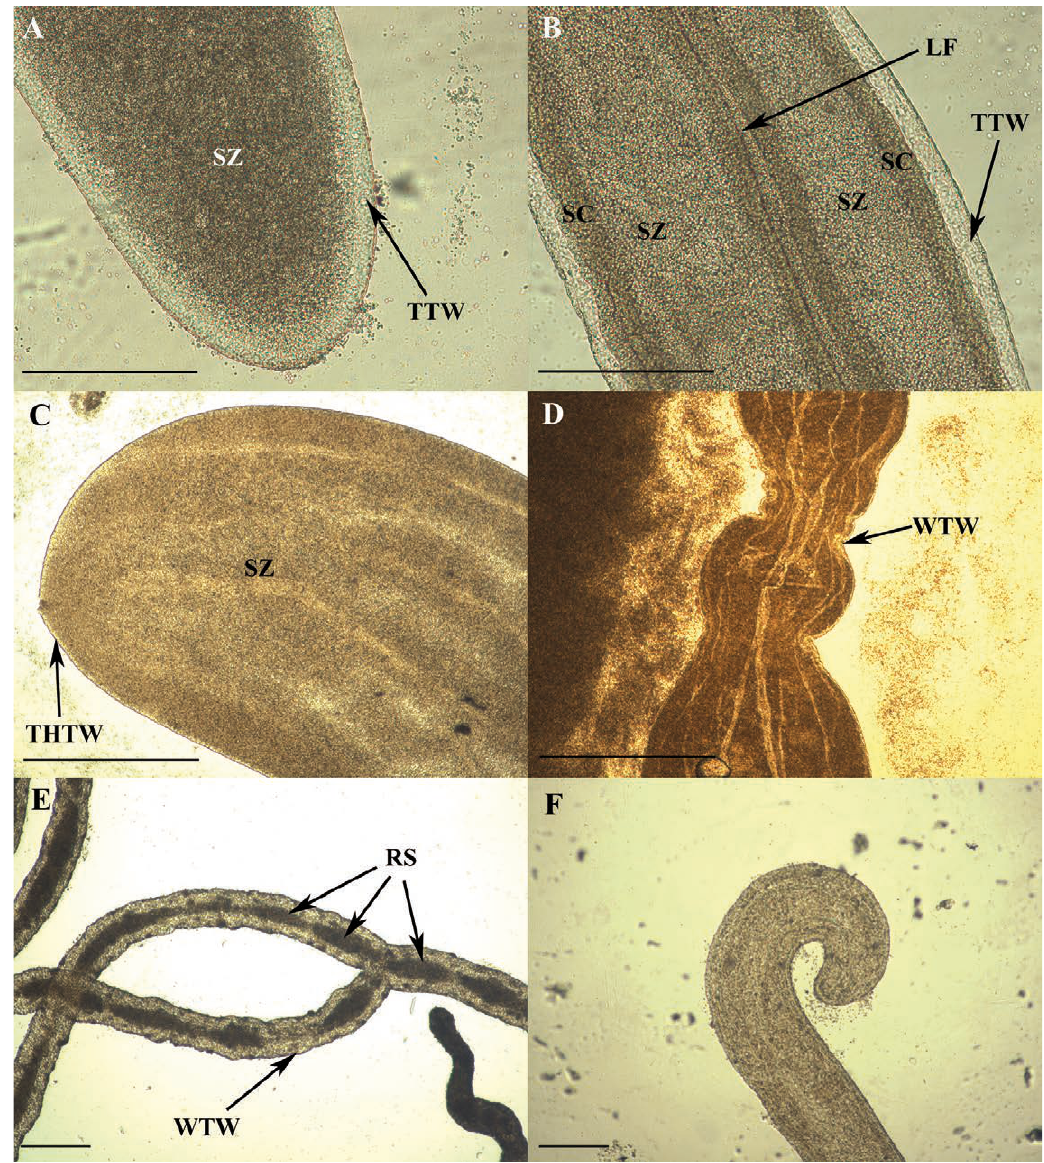
Fig . 8. – Light micrographs of male H. sanctori stages of maturity. A, growing tubule with spermatozoa (SZ) and with thick tubule walls (TTW). B, growing tubule with longitudinal fold (LF) surrounded by spermatozoa (SZ) and spermatocytes (SC) at both sides of it; C, tubule completely full of spermatozoa (SZ) and thin tubule walls (THTW); D, partly spawned tubule with wrinkled tubule wall (WTW) and marked folds; E, completely spent tubule showing wrinkled tubule walls (WTW) and relict spermatozoa concentrations (RS) in lumen. F, detail of a completely spent tubule with rolled up end. Scale bars: 250 µm; A-B, stage II; C, stage III; D stage IV; E-F, stage